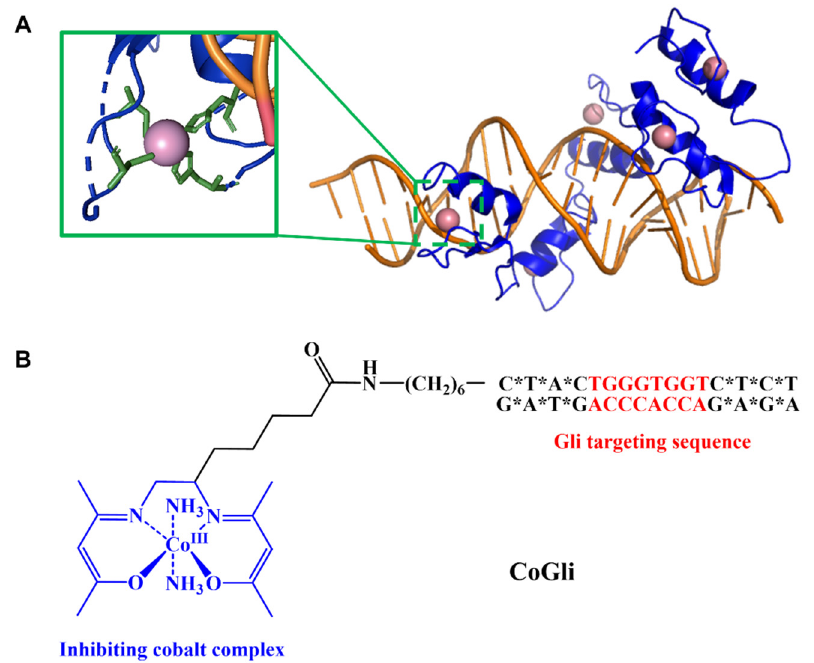
Figure 6. An inorganic inhibition approach for Gli. ( A ) Structure of the Gli binding domain co-crystalized with its native DNA binding partner (structure produced from PDB entry 2Gli). Inlet shows Cys 2 His 2 zinc(II) coordination site that locks alpha-helical secondary structure into place. ( B ) Structure of CoGli, a cobalt-based inhibitor of Gli transcription factors. The Gli targeting sequence imparts specificity for Gli proteins and the cobalt complex displaces zinc ions. Evaluation of this complex in 2D BCC assays produced 50% inhibition of Hh-driven cell migration at 300 nM compared to 5 µM GANT-61. * Denotes phosphorothioate linkages to evade degradation by endonucleases.